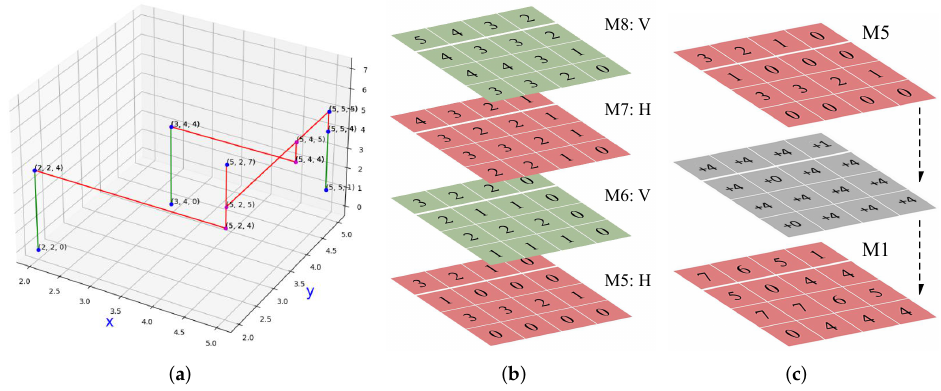
Figure 5. An example of 3D BFS search process in Algorithm 3. The z -coordinate of the removed pin is M 1 and its minimum layer is M 5. ( a ) Routing paths of a net, where the red and green lines represent the routing path on the minimum layer and via, respectively. ( b ) The distance map above the minimum layer, where the red layer direction is horizontal and the green layer direction is vertical. ( c ) The distance map of layer M 1 is directly calculated from the distance map of the minimum